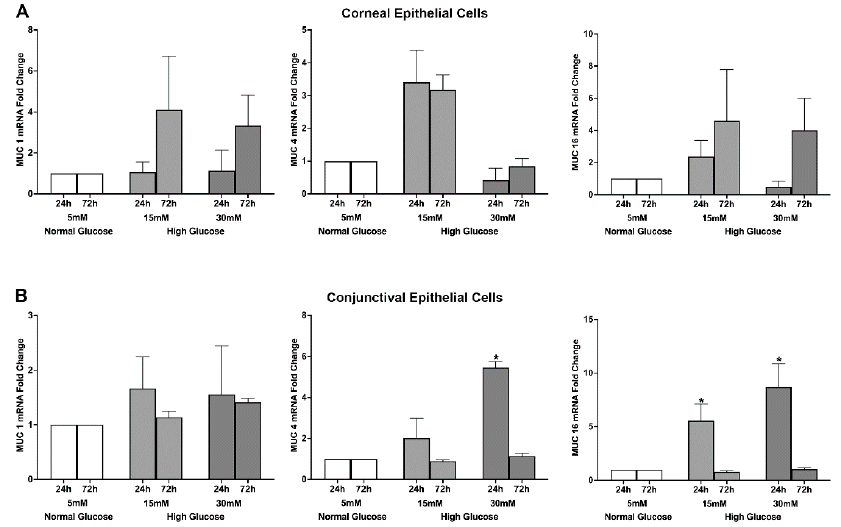
Figure 1. ( A ) Effect of a high glucose level (15 mM; 30 mM) on MUC 1, 4, and 16 gene expression in